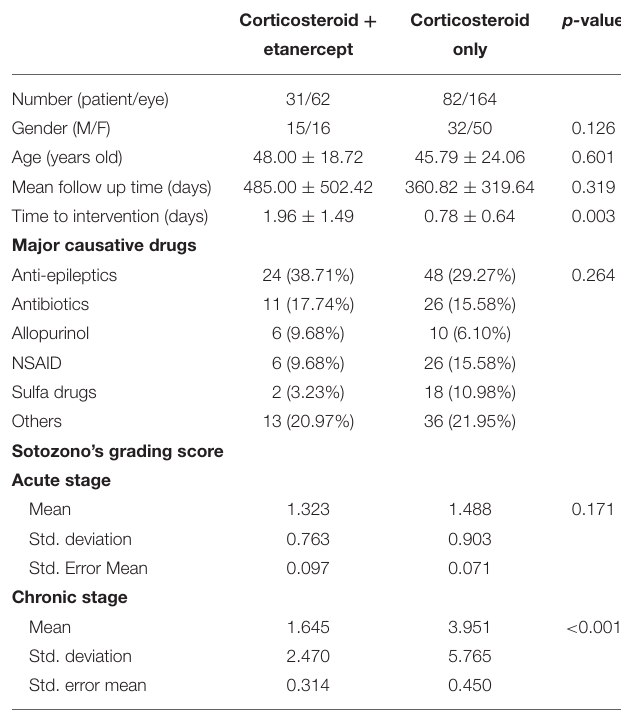
TABLE 3 | Ocular manifestations in chronic stage of SJS/TEN patients.